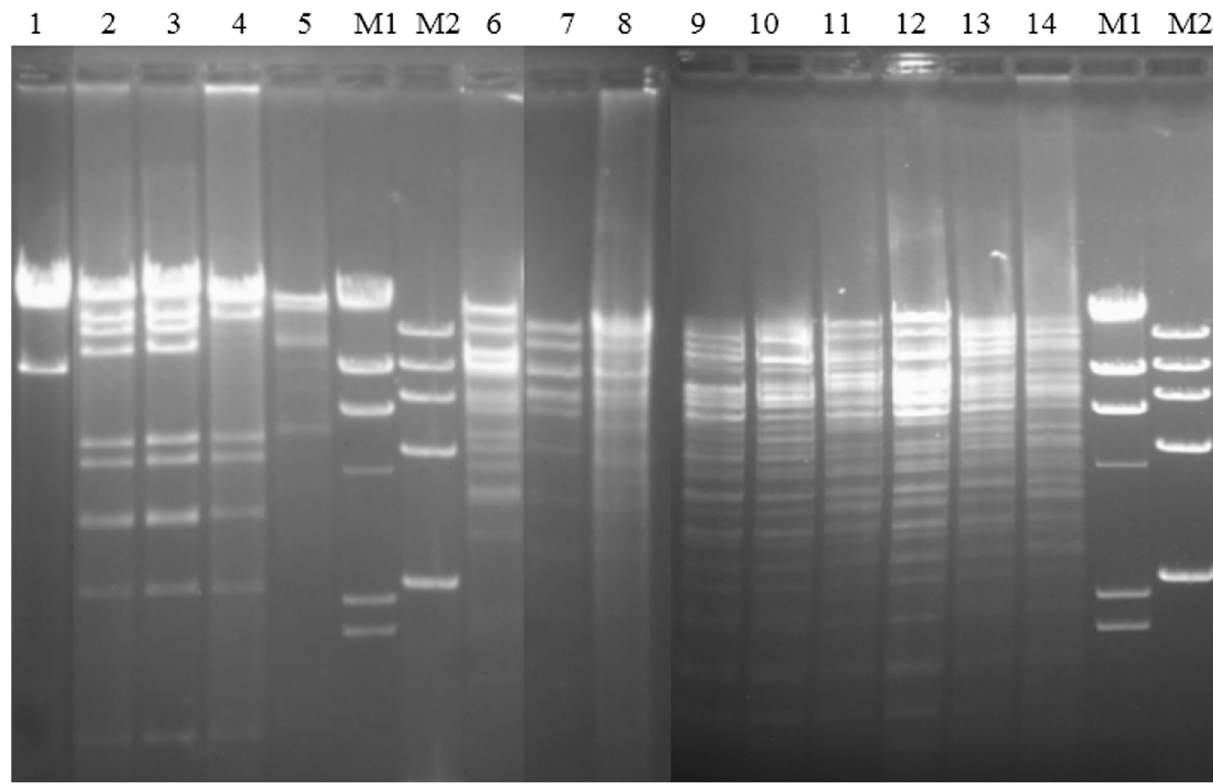
Figure 2. EcoR I restriction digestion profiles of plasmids co-harboring oqxAB - bla containing only one plasmid. Lanes 1–14: A6T, 42-2T, FS5E1DT, FS2Y1XT, FS6J2CT, 7ganT, 33-2T, FS3Z3CT, 45-6T, 2YG4T, A64T, A78T, FS1Z4S, and CBJ3CT; Lane M1: λ- Hind III marker; Lane M2: DL15000. doi: